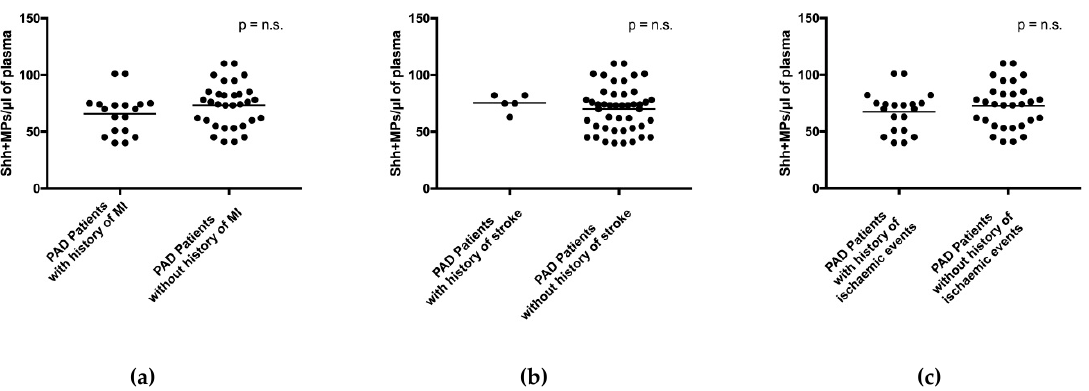
Figure 3. Global number of Shh + MPs in PAD patients with and without history of myocardial infarction (MI) ( a ), with and without history of stroke ( b ), and with and without history of either MI and/or stroke ( c ). p : p-value; n.s .: not significant. Black horizontal lines in panels indicate median values.